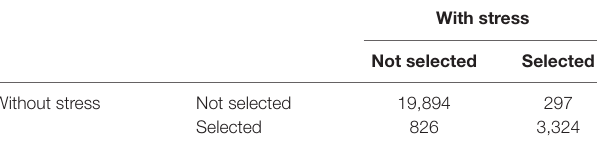
TABLE 11 | Confusion matrix of coincidence between selected 4,150 genes for samples without stress and selected 3,621 genes for samples with stress among all 24,341